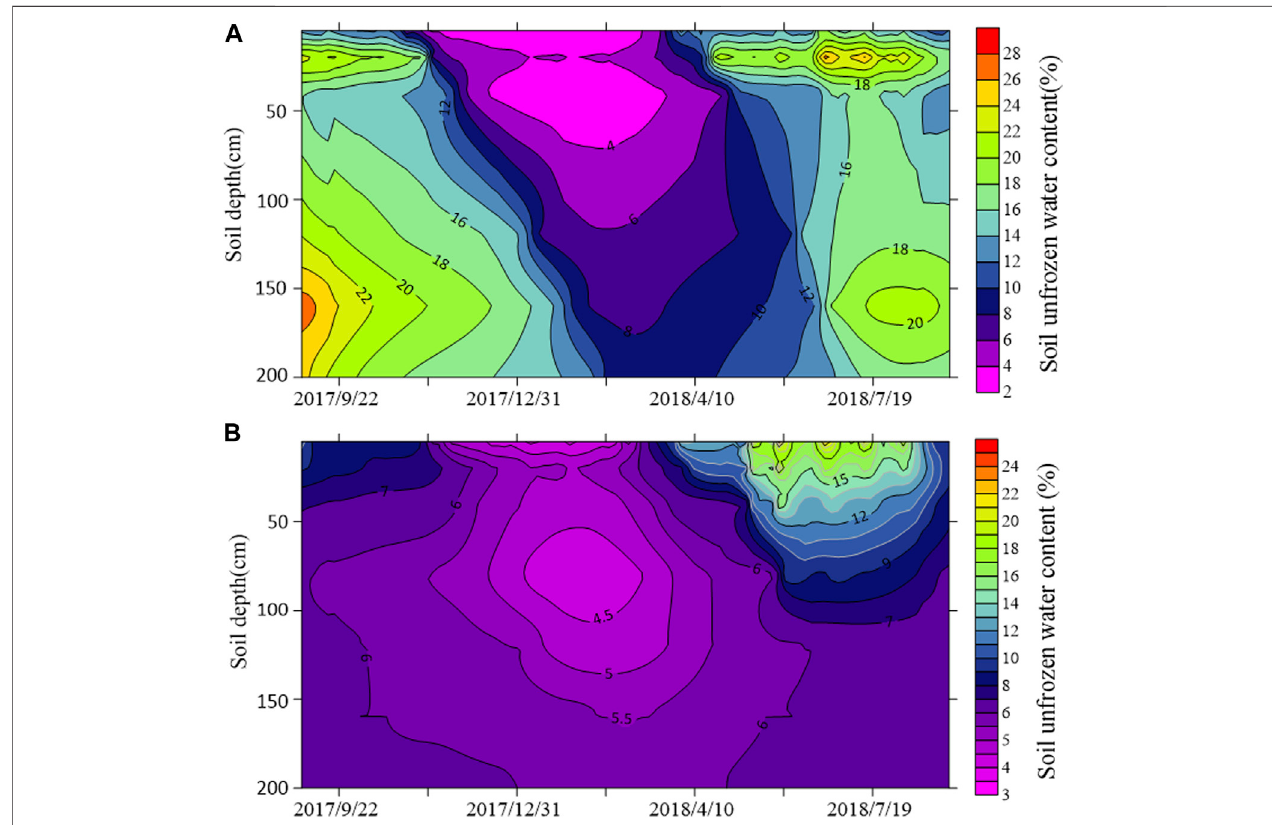
Frontiers in Earth Science |